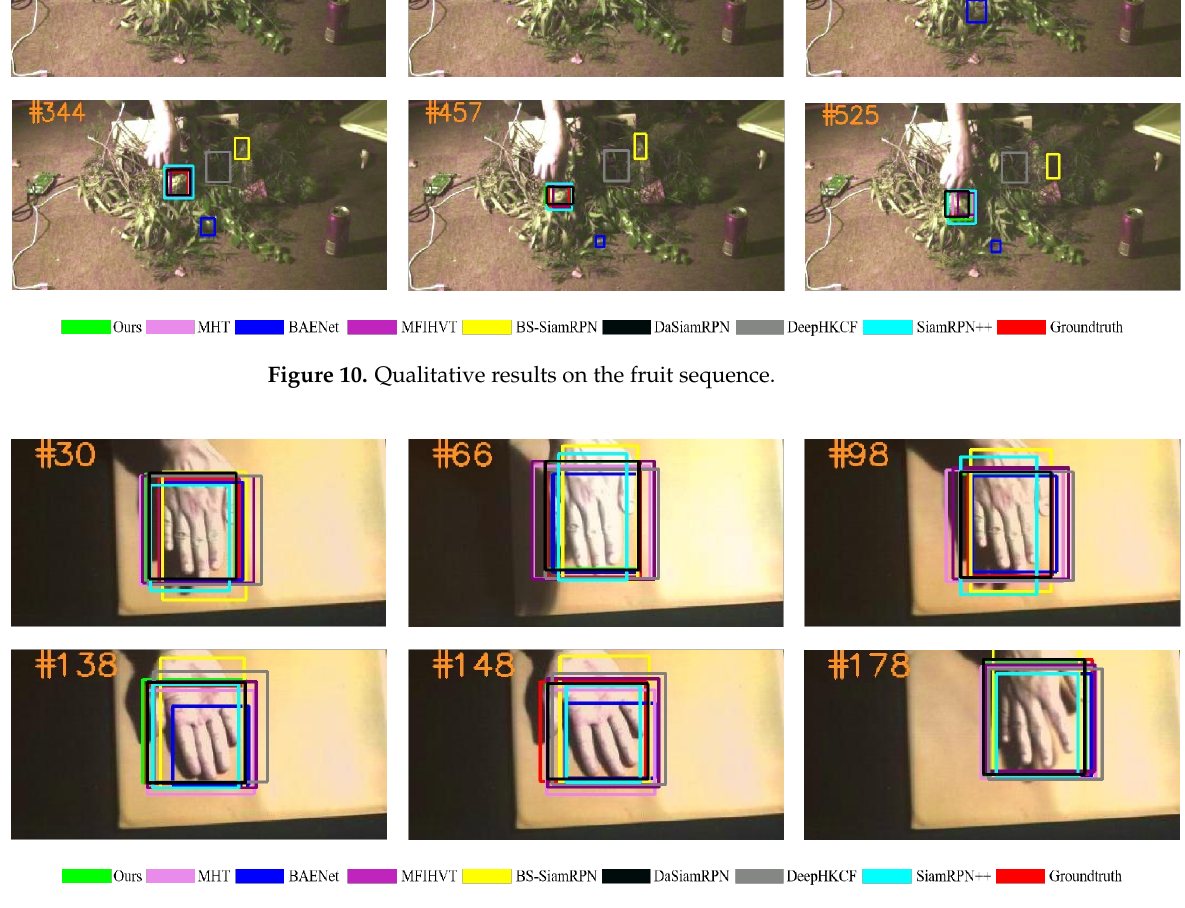
Figure 11. Qualitative results on the hand